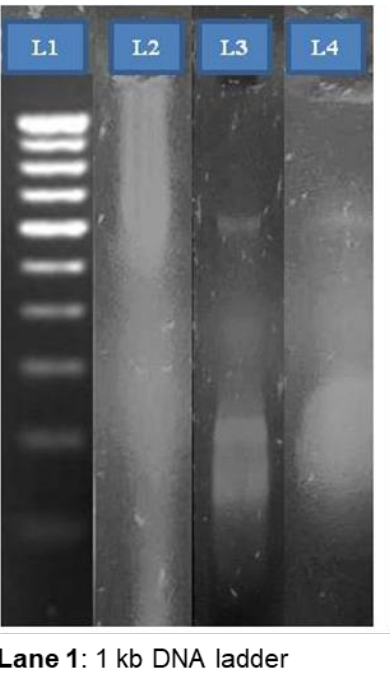
Figure 8. DNA fragmentation analysis of biogenic AgNPs on different cancerous cells.